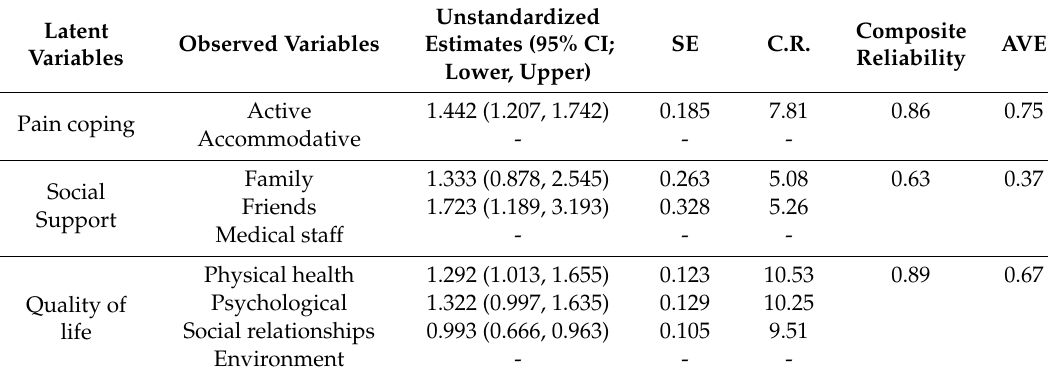
Table 2. Confirmatory factor analysis of the measurement